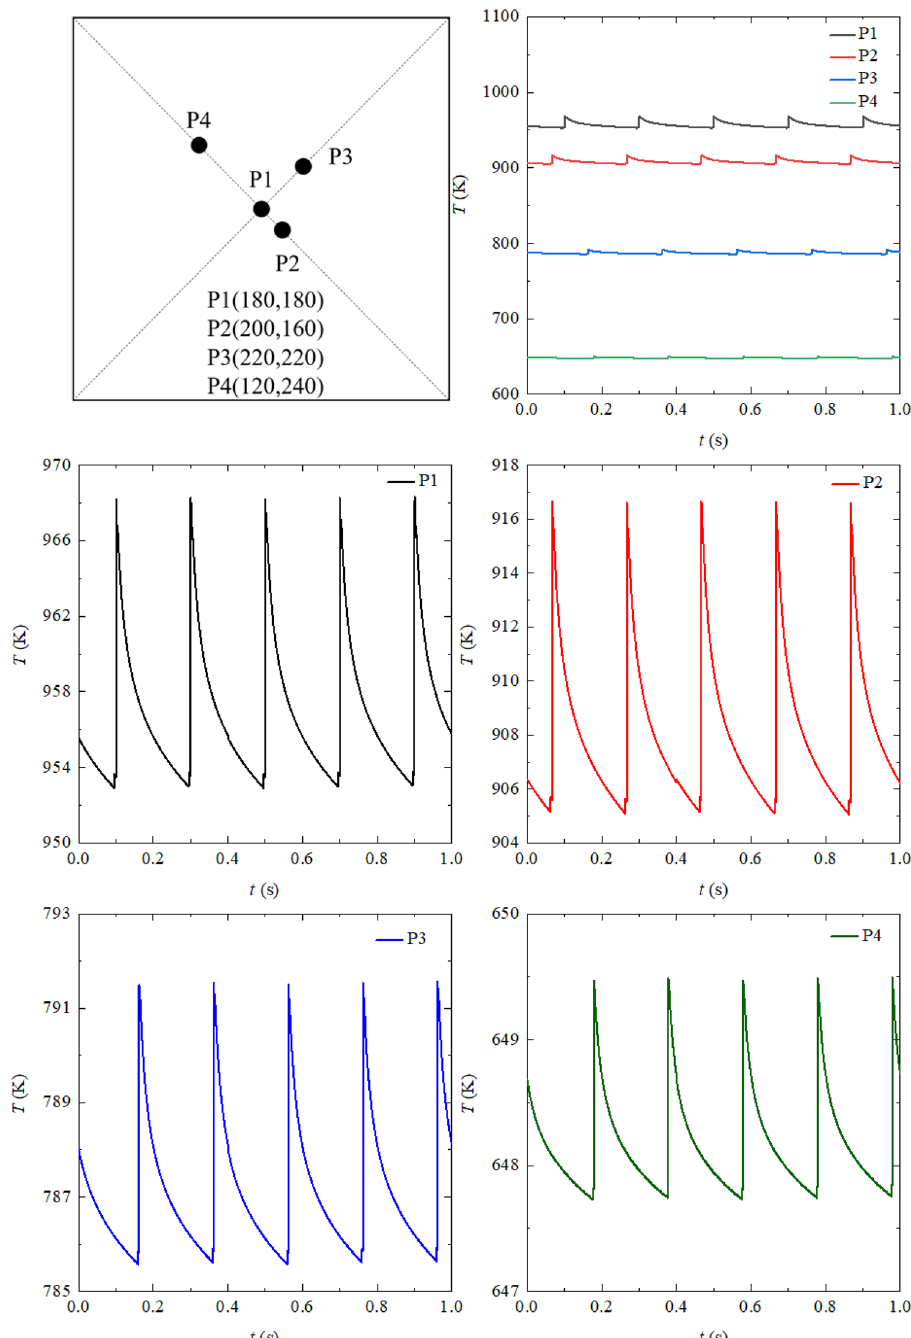
Figure 7. The simulated temperature fluctuation results of P1–P5 in 1